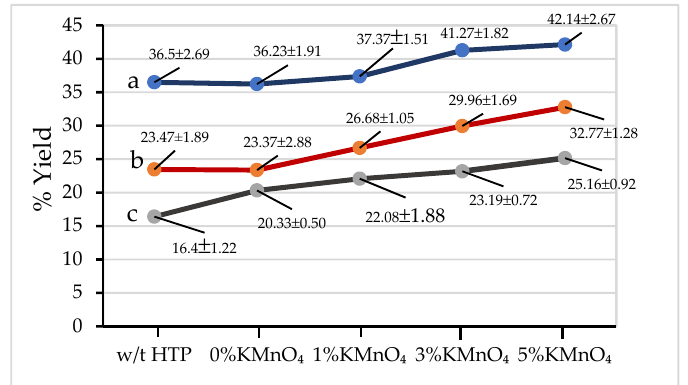
Figure 2. Percent yield of activated carbon materials made with or without hydrothermal pretreat- ment and with addition of KMnO 4 of 0–5% by weight at ( a ) 300 °C ( b ) 350 °C and ( c ) 400 °C.